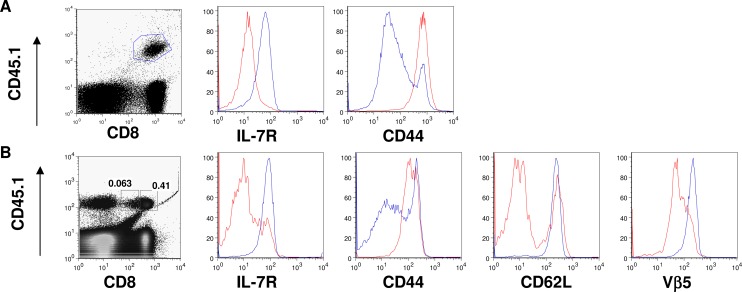
Cross-presentation of endogenous self antigen by immature DCs down-regulates IL-7R expression on auto-reactive CD8 T cells.A: 2x 106 purified CD45.1+ OT-I T cells were transferred into CD45.2+ RIP-mOVA mice (n = 5). At day 7 after transfer, lymphocytes were recovered from the pancreatic draining LNs and distal LNs. OT-I T cells were identified by flow cytometry using CD45.1 marker and their expression of IL-7R and CD44 were determined (pancreatic LNs-red line, distal LNs-blue line). The results are representative of at least 3 independent experiments. B: 2x 106 CD45.1+ total spleen T cells from Vβ5xRIP-mOVA mice were transferred into K14-mOVA mice (n = 5). At day 7 after transfer, lymphocytes were recovered from the skin draining LNs and transferred T cells were identified by CD45.1. Autoreactive and non-autoreactive CD8 T cells were distinguished by their level of CD8 expression (CD8 low- autoreactive, CD8 high- non-autoreactive) and their expression of IL-7R, CD44, CD62L, and Vβ5 were determined using flow cytometry (CD8 low–red, CD8 high-blue). Similar results were obtained from two independent experiments.